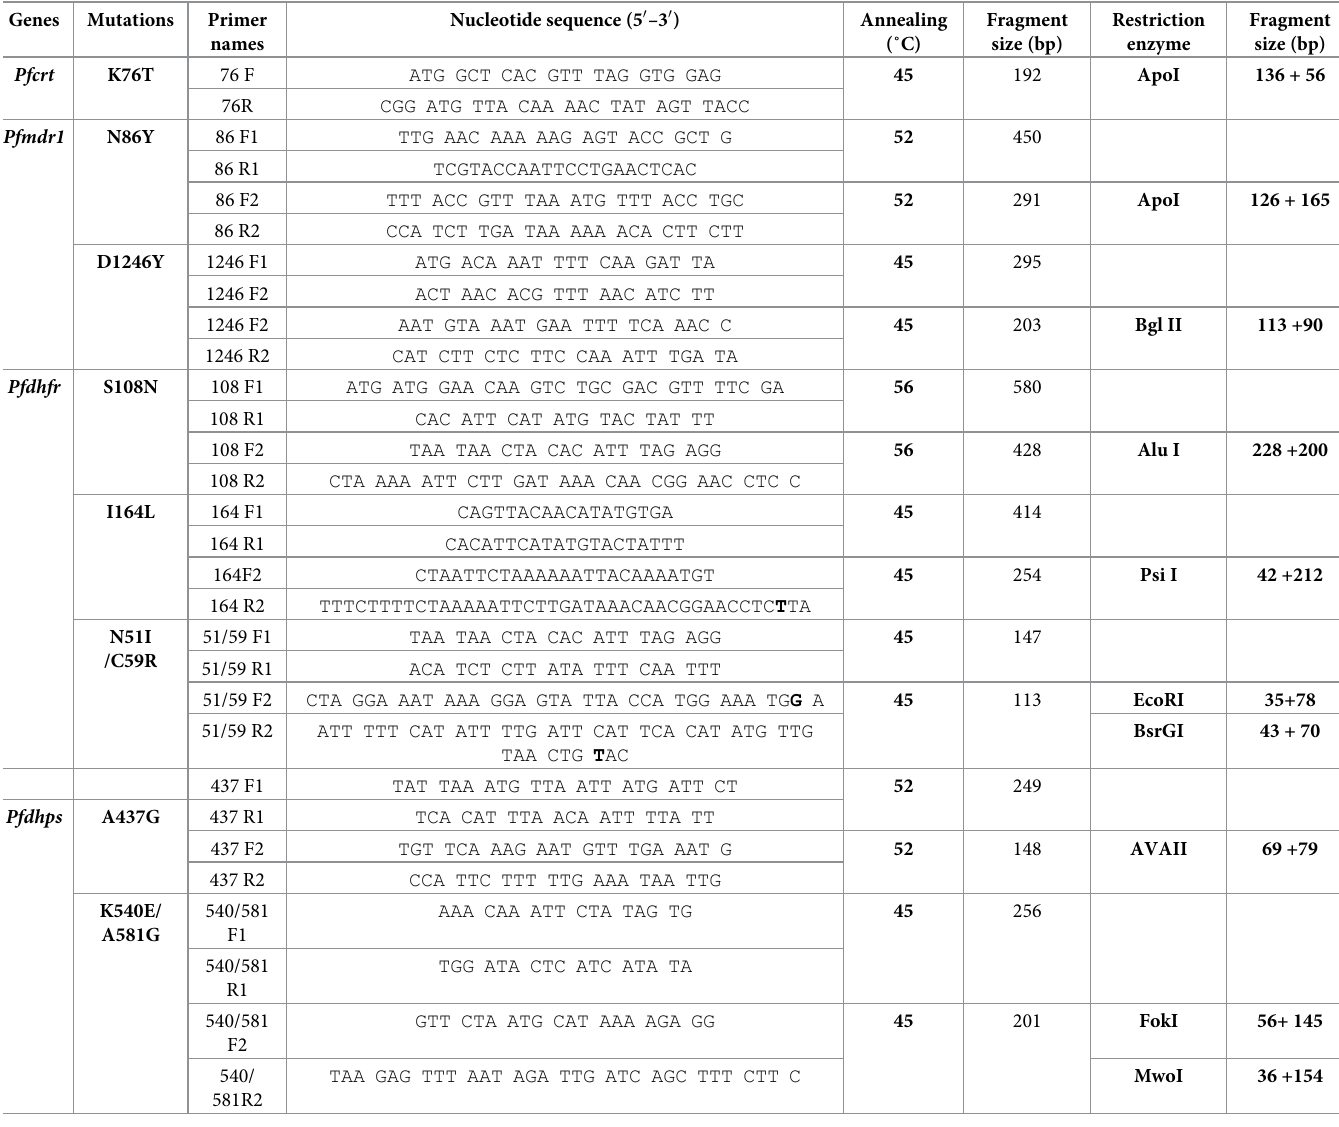
Table 1. Characteristics of the primers used for PCRs and enzymes for ASRA. Genes